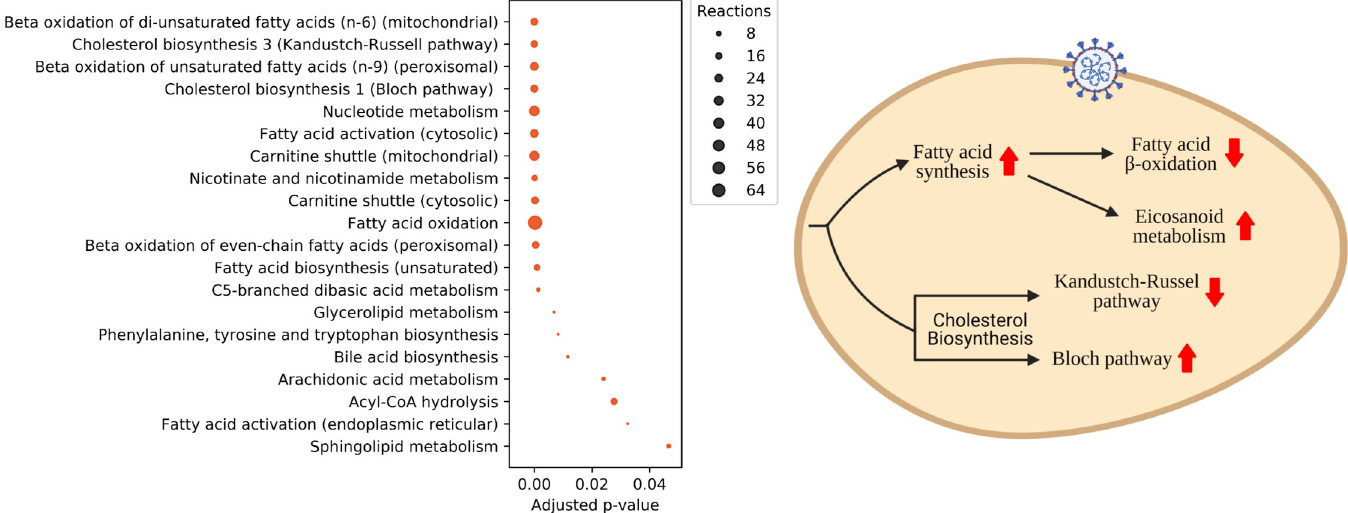
Fig 6. GS-DFA reveals altered pathways in infected cells and post-translational modifications in infected cells are enriched in altered reactions. (A) Enriched pathways (subsystems) in the SARS-CoV-2 infected NHBE cells as revealed by GS-DFA analysis. The presented reactions have flux change (as described in materials and methods) greater than 0.82 and have adjusted p-value less than 0.05 (B) Some of the pathways altered in the SARS-CoV-2 infected cells that could have therapeutic relevance (Created with BioRender.com).